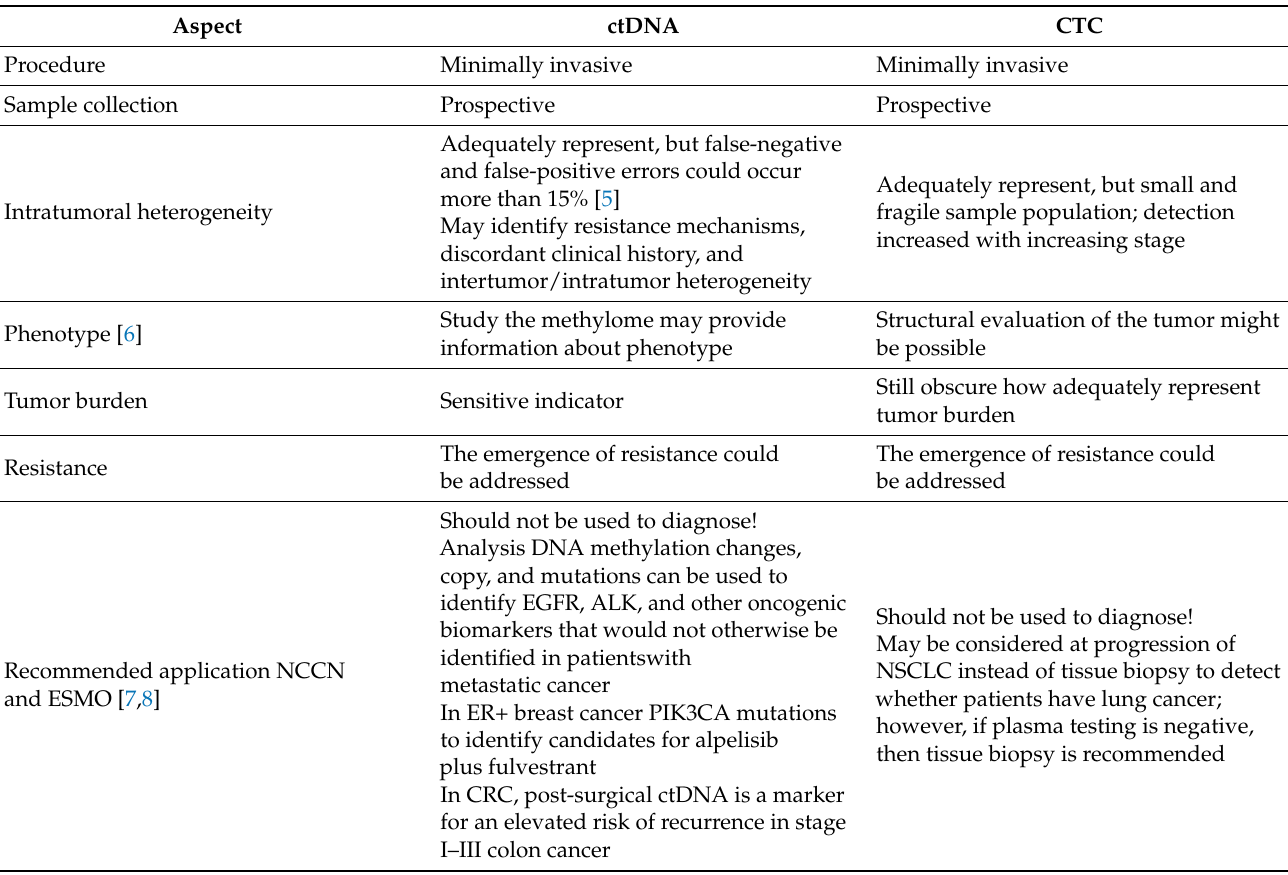
Table 1. Comparison of CTC and